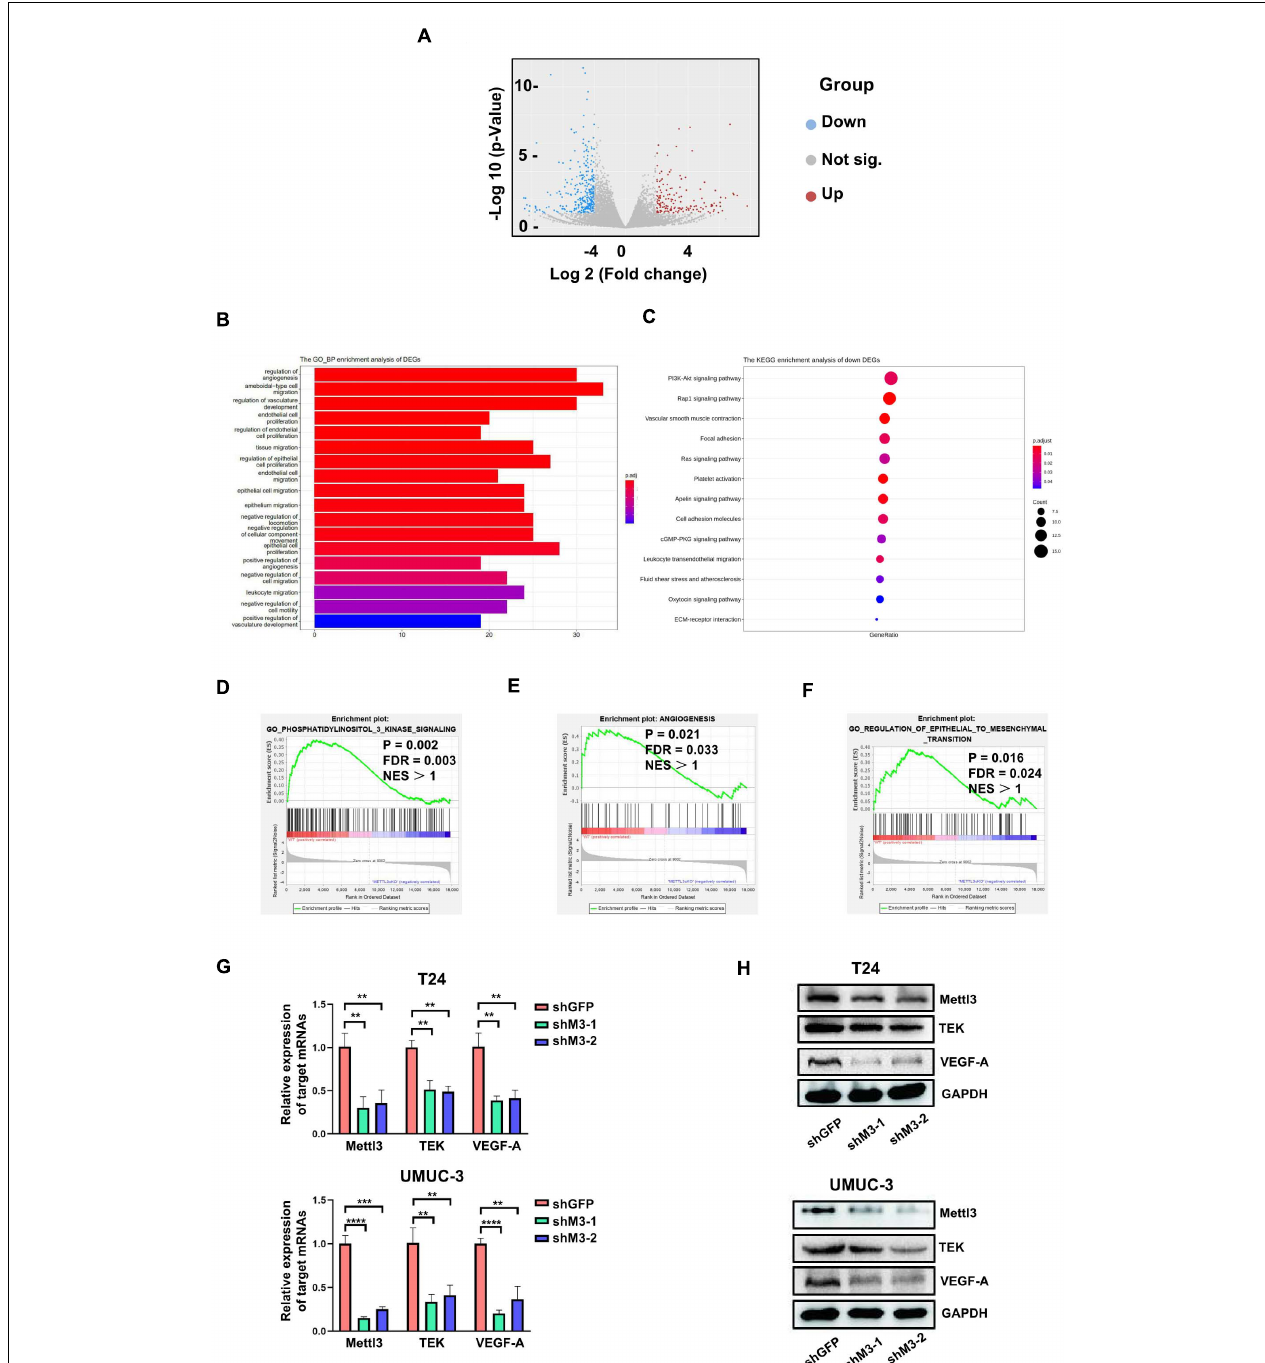
FIGURE 4 | RNA-sequencing reveals Mettl3 regulates PI3K pathway and angiogenesis in bladder cancer (BCa). (A) The differentially expressed genes (DEGs) were shown by volcano scatterplot. Blue dots represented downregulated genes by deletion of Mettl3, gray for not significantly changed, and the red one for the upregulated genes. (B) The Gene Ontology Biological Process enrichment analysis of DEGs identified the most relevant function modulated by Mettl3. (C) The Kyoto Encyclopedia of Genes and Genomes (KEGG) enrichment analysis was conducted to examine downstream signaling pathway by monitoring down DEGs. (D) Gene Set Enrichment Assay plots of Gene Ontology (GO) phosphatidylinositol 3 kinase signaling for Mettl3-regulated genes from RNA-seq datasets. (E) Gene Set Enrichment Assay plots of angiogenesis for Mettl3-regulated genes from RNA-seq data. (F) Gene Set Enrichment Assay plots of GO regulation of epithelial to mesenchymal transition for Mettl3-regulated genes from RNA-seq datasets. (G) Quantitative PCR (qPCR) and Western blot analyses were conducted to measure the expression of AKT1 or BCL9L at messenger RNA (mRNA) and protein level in BCa cell lines. (H) The transcripts and proteins level of tyrosine kinase endothelial (TEK) and vascular endothelial growth factor A (VEGF-A) were examined by qPCR and Western blot experiments in vitro . ** p < 0.01; **** p < 0.0001.